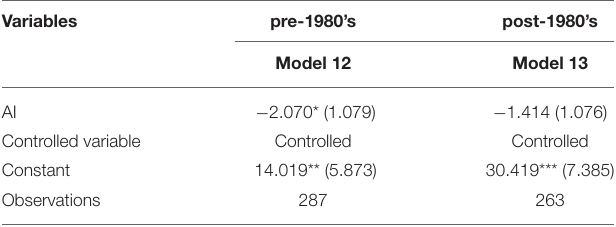
TABLE 7 | Heterogeneity in the impact of AI on the mental health of manufacturing workers: pre-1980’s vs.